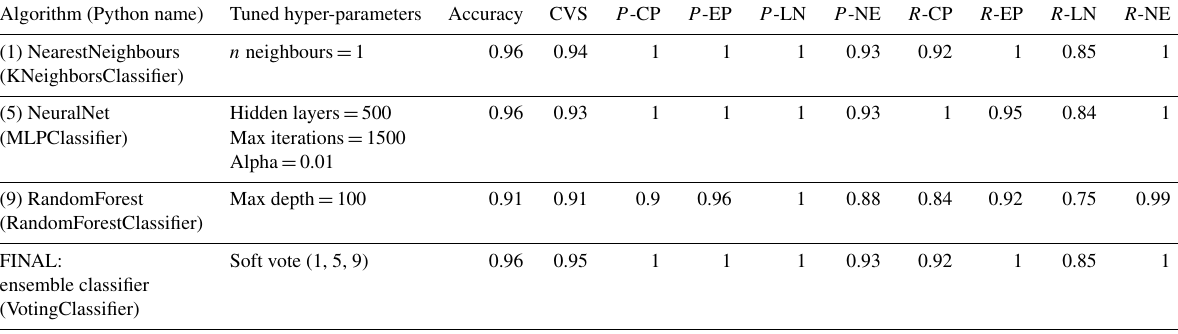
Table 2. Scores for different algorithms tested. Scores are defined in Sect. 2.2. Details on the tuning of the hyper-parameters can be found at https://github.com/nicolamaher/classification (last access: 22 August 2022).